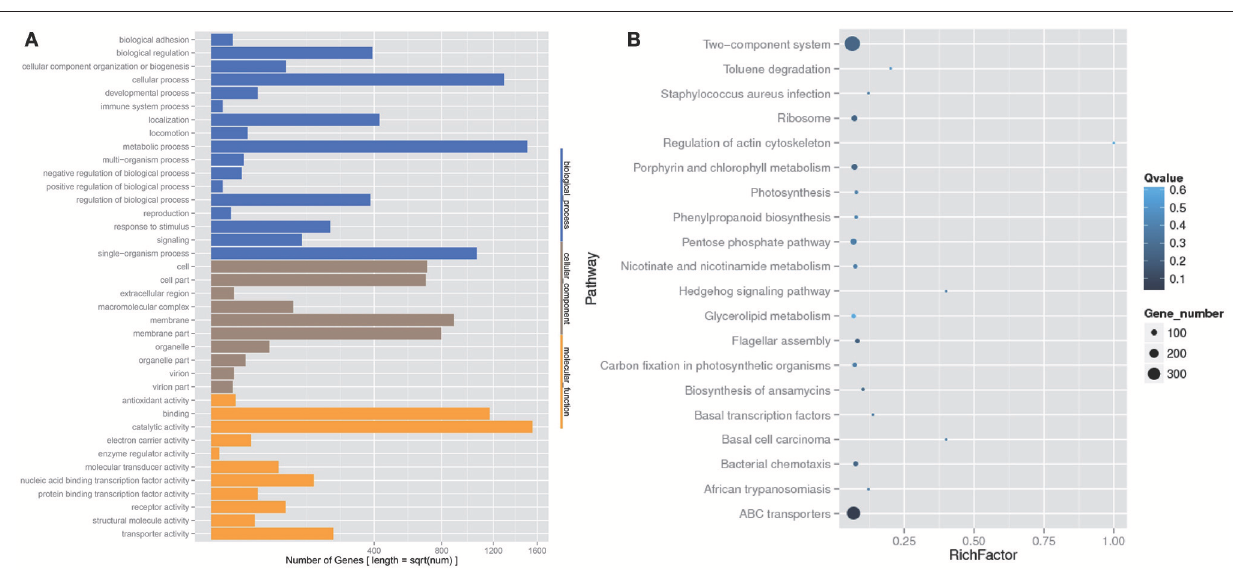
FIGURE 6 | KEGG pathway and Gene Ontology (GO) classification analysis of genes with different abundance between the group A and B samples. (A) GO functional classification. (B) Top 20 statistics of pathway enrichment for A group vs. B